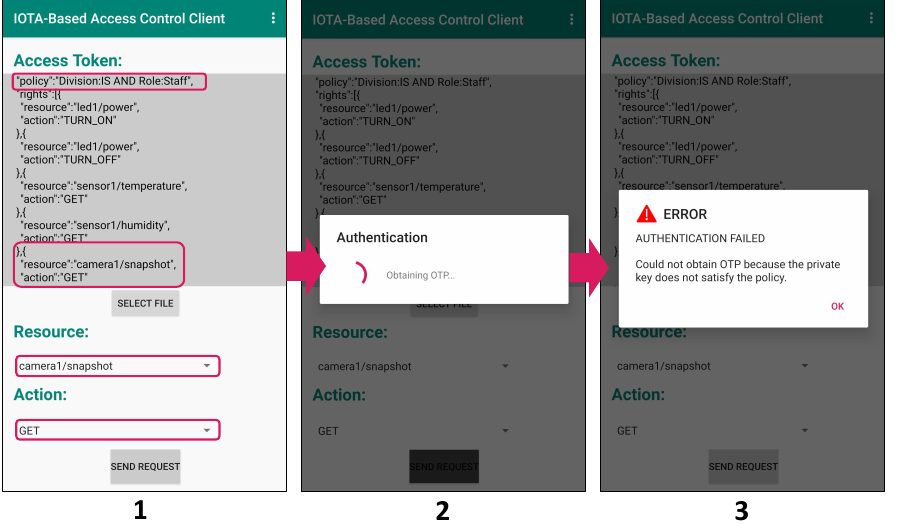
Figure 15. Denied access due to stolen